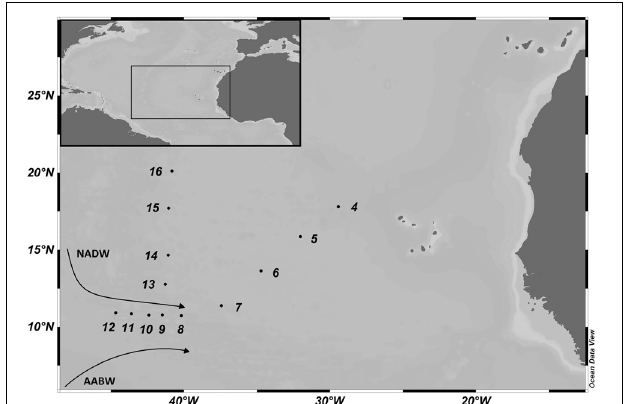
FIGURE 1 | Map of the study area in the (sub)tropical North Atlantic Ocean with the sampling sites occupied during the MOCA cruise in 2010. The cruise track is divided into northern (Stations 13–16) and eastern (Stations 4–7) section and the Vema Fracture Zone (Stations 8–12). The flow direction of the main deep-water masses, the North Atlantic Deep Water (NADW) and Antarctic Bottom Water (AABW) is